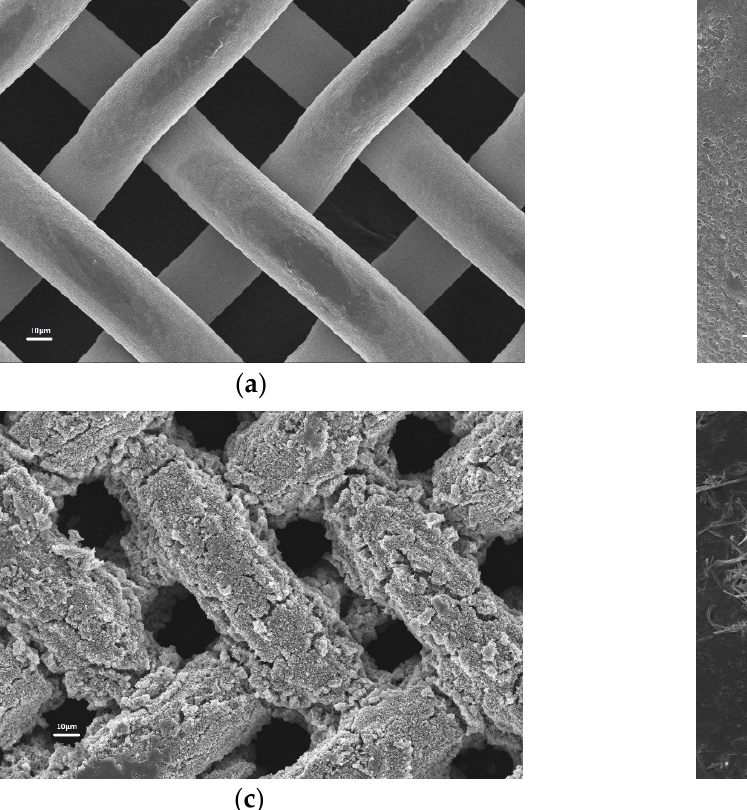
Figure 2. Morphological and compositional analysis of TiO 2 . TEM of P25 ( a ) and TiO 2 fiber ( b ), and XRD of P25 and TiO 2 fiber ( c ).